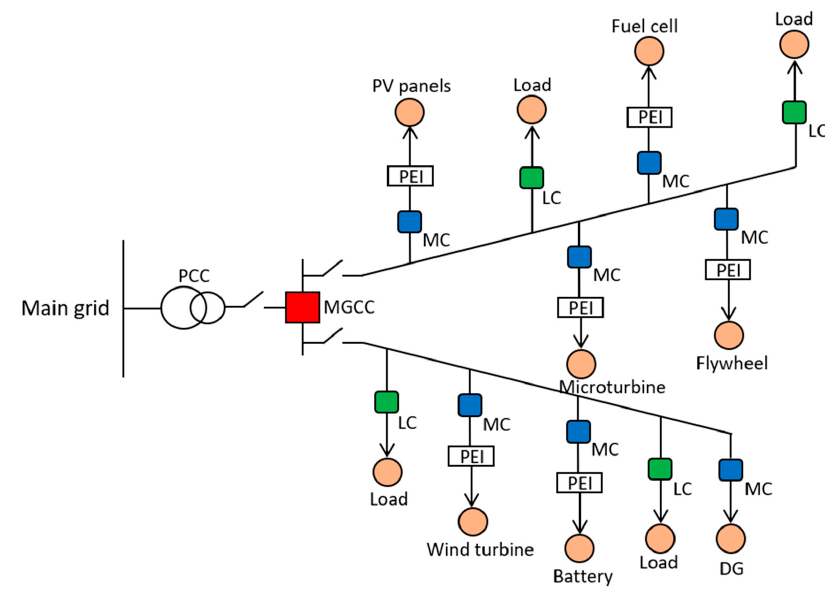
Figure 3. Microgrid structure and control components with example ESSs.